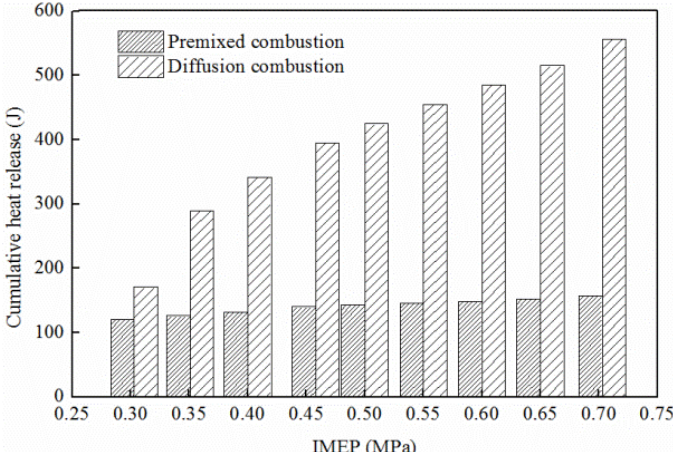
Figure 8. CHR at different